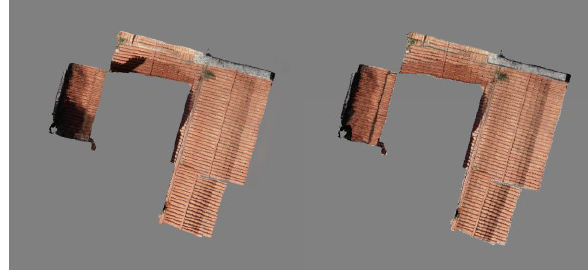
Figure 9. The roof tiles before and after colour